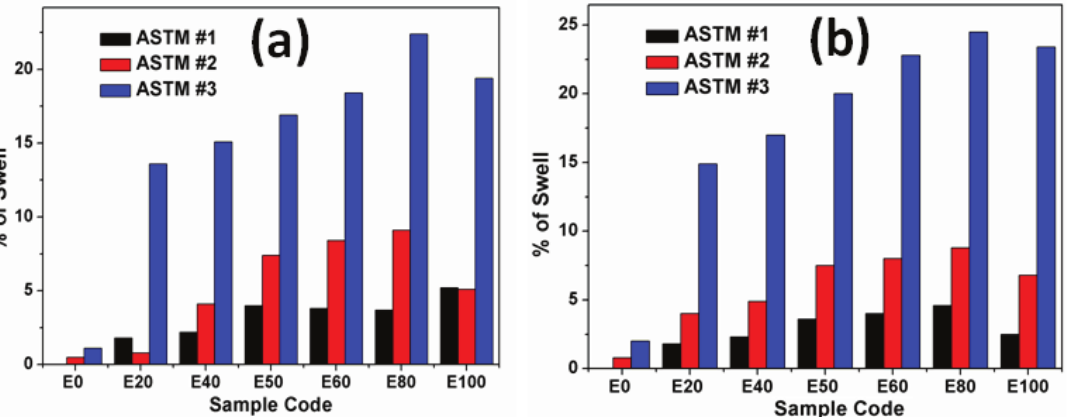
Figure 8: Oil resistance characteristics of the pristine EMA, NBR and their various blends (a) at room temperature (b) at elevated temperature of 50 °C.